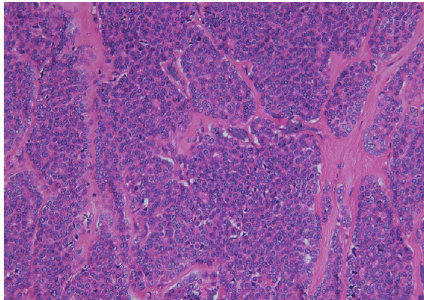
Figure 2: Pathological diagnosis of poorly differentiated carcinoma derived from follicular thyroid carcinoma with minimal invasion; Victoria Blue hematoxylin and eosin staining, 200x.